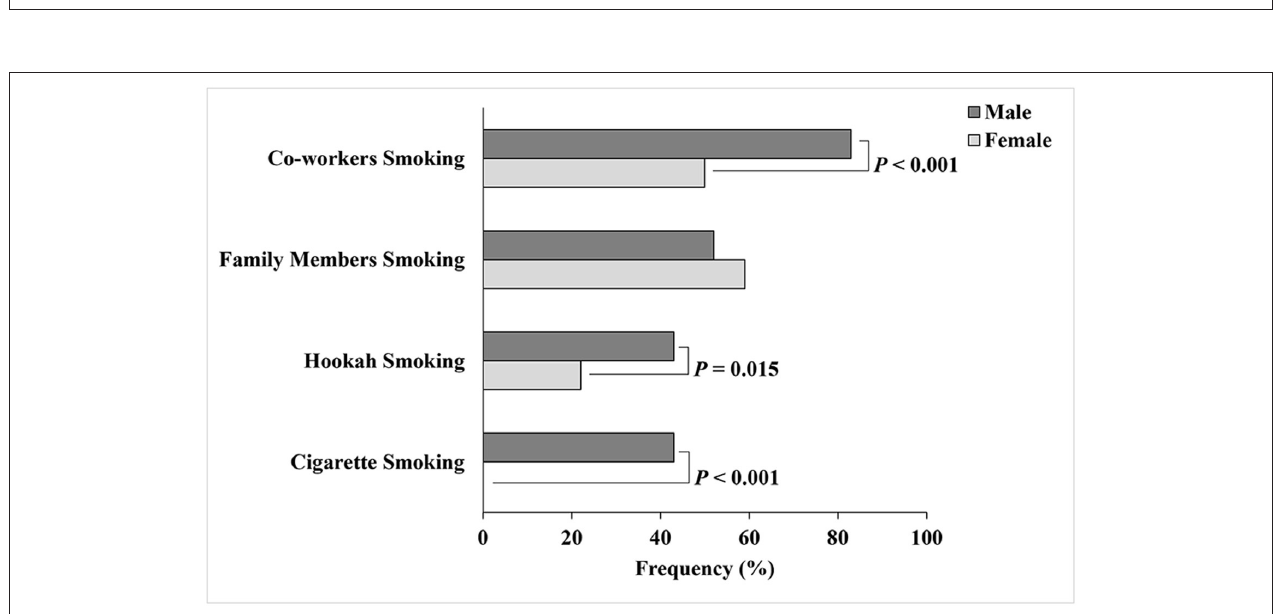
FIGURE 2 | Smoking status of male and female college students, family members, and co-workers.